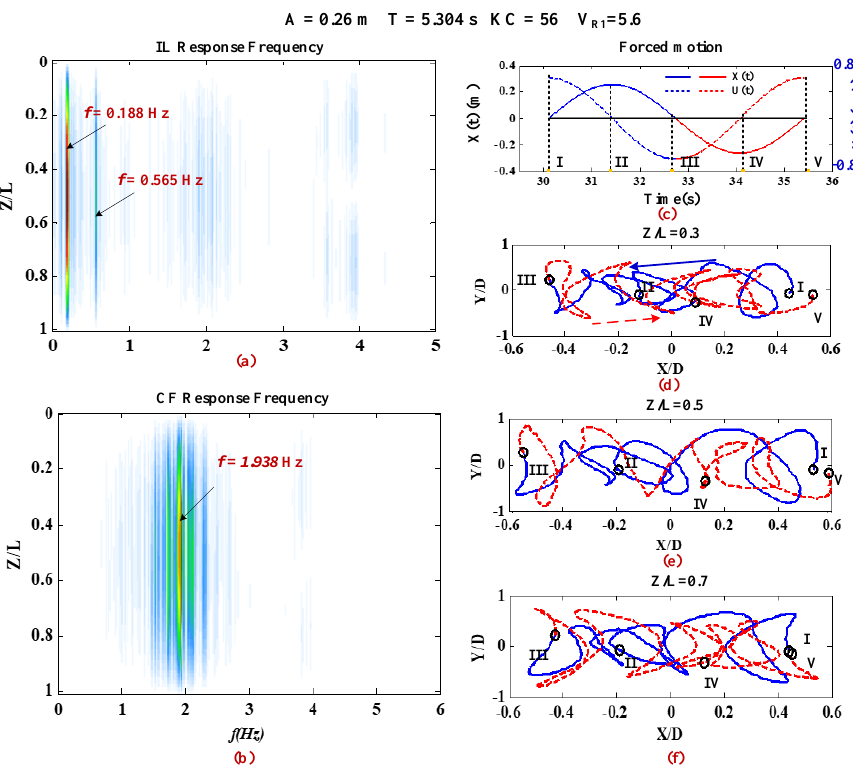
Figure 15. The spatial distribution of response frequency and displacement trajectories at different positions when KC = 56 and V R1 = 5.6. Table 4. Summary of dominant frequency of VIV for different test cases.